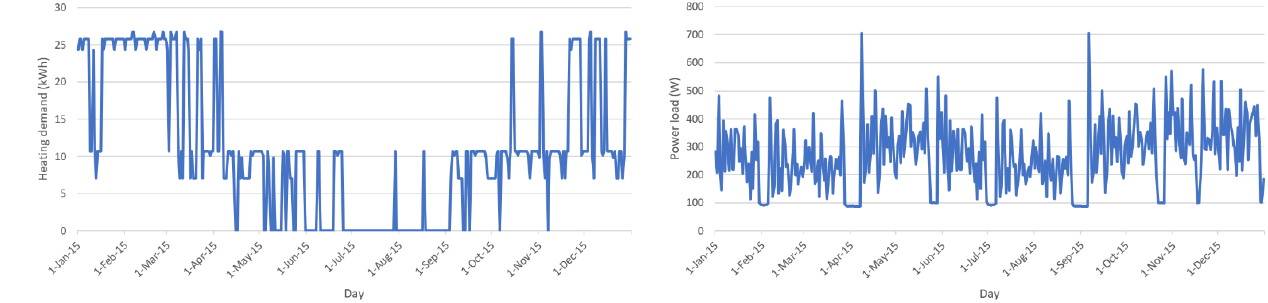
Figure 2. Input heat demand profile ( left ) and electrical load curve ( right ) over one year.